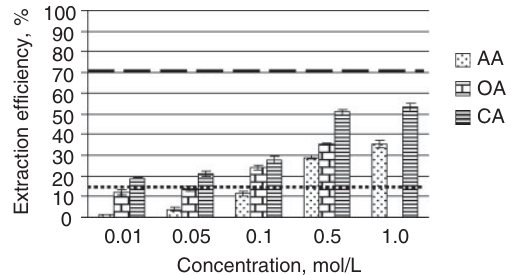
Fig. 3. The nickel extraction efficiency (%) using various concentrations of organic acids: AA, acetic acid; OA, oxalic acid; CA, citric acid. Below the dotted line; the HM percentage in the mobile fractions (F1 (cid:3) F2); between the dotted and dashed lines, the HM percentage in the poten- tially mobile fractions (F3 (cid:3) F4); above the dashed line, the HM percentage in the immobile fraction